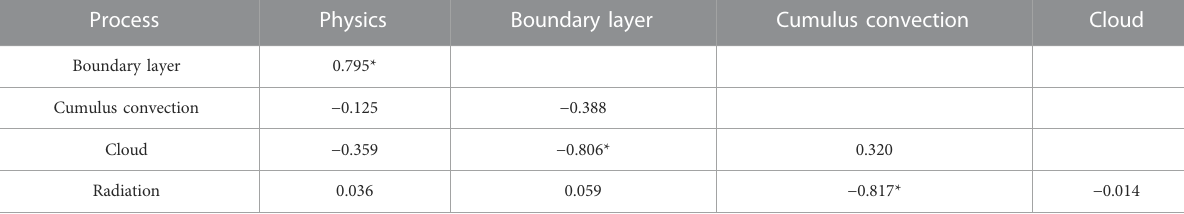
TABLE 4 Correlation coef fi cients of the temperature tendencies for each process in the